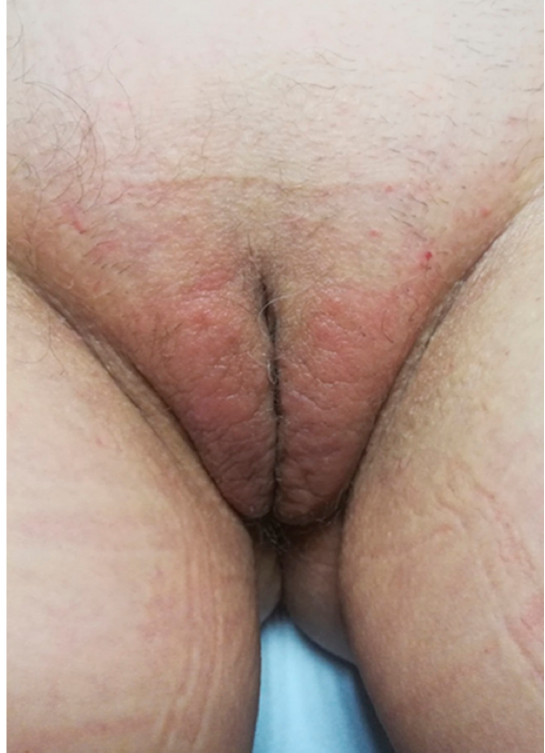
Figure 2. Lichenification following persistent allergic contact dermatitis.